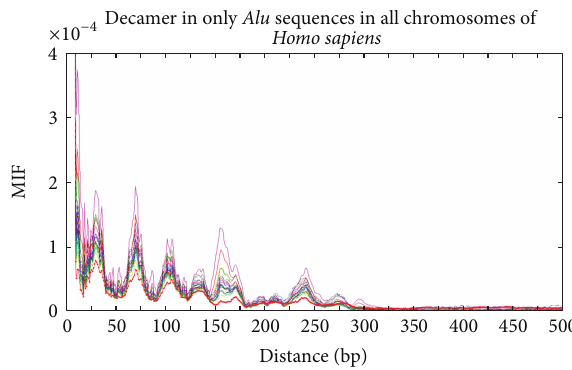
Figure 5: MIF profiles of the R/Y decamer in only Alu sequences in all Homo sapiens chromosomes.